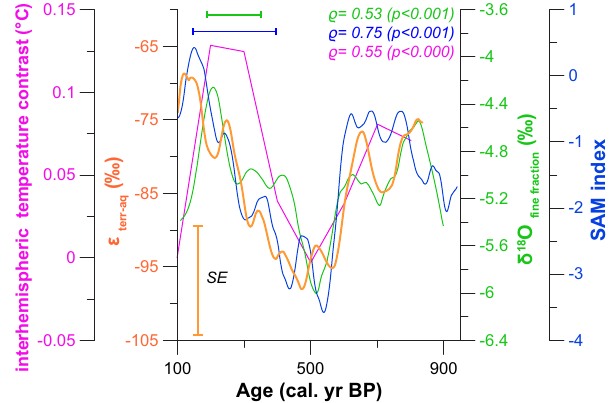
Fig. 8 Comparing inferred ε terr-aq values from Lake Diamond (orange) with other regional proxies of wind-driven change. In blue, the Southern Annular Mode (SAM) index by ref. 12 . And in green, the δ 18 O fi ne fraction SHW record from Lago Guanaco by ref. 21 . Shown in purple is the area- weighted inter-hemispheric temperature contrast between the extratropics (30 – 90°) of both hemispheres (North-South) using 30° averages of ensemble means presented by ref. 110 . All reconstructions have been smoothed using a 70-year moving average. In the upper part of the fi gure, we show chronological uncertainties (horizontal bars) and correlation coef fi cients (italics) in matching colors. The vertical bar at the base marks the reported standard error (SE) of our PTP-derived model (see